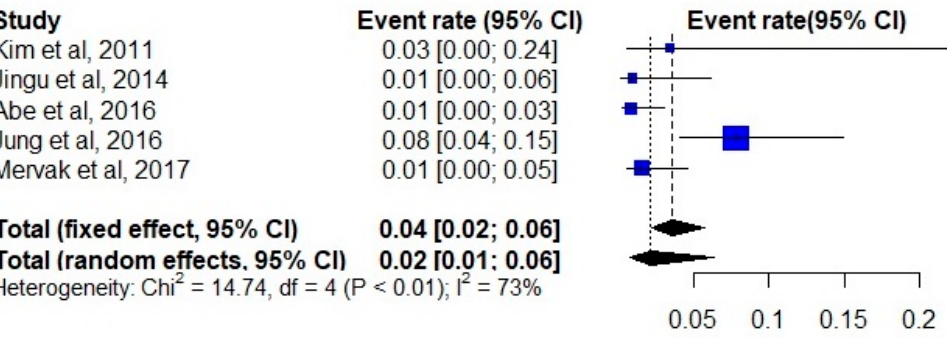
Figure 3. Forest plot of the event rate of hypersensitivity reactions in premedicated patients. [29,26,30,28,27].